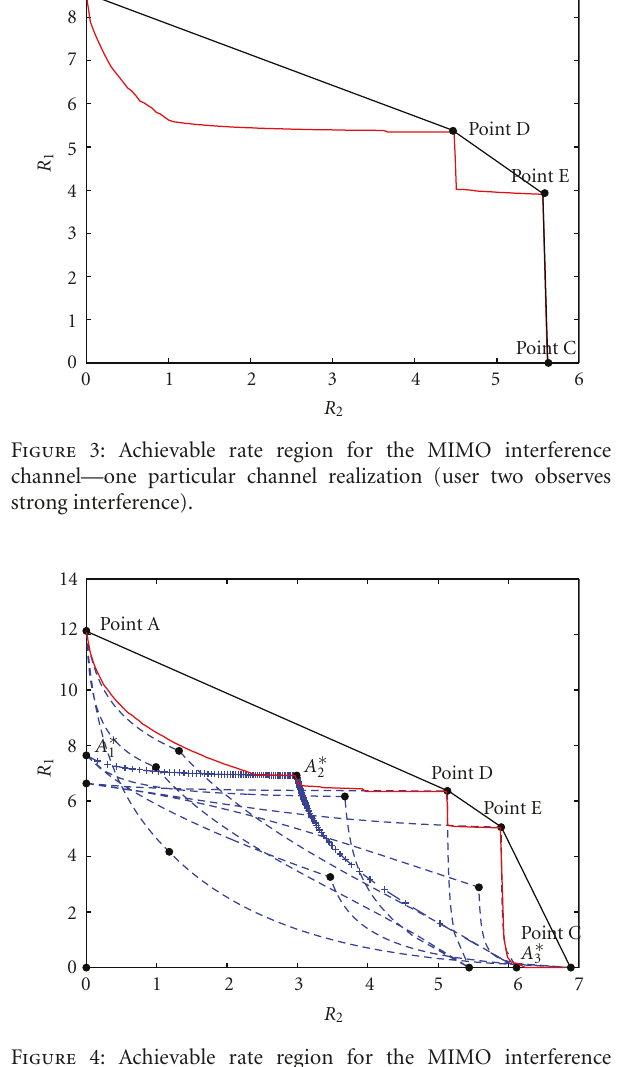
Figure 4: Achievable rate region for the MIMO interference channel—the transmit power of the first user is twice higher than the transmit power of the second user.